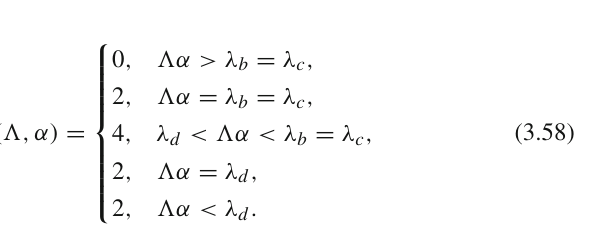
Fig. 1 The function λ( x ) = (cid:2)( x )α for α > 0, l = 3 ( A ) l = 3. In this subcase λ 0